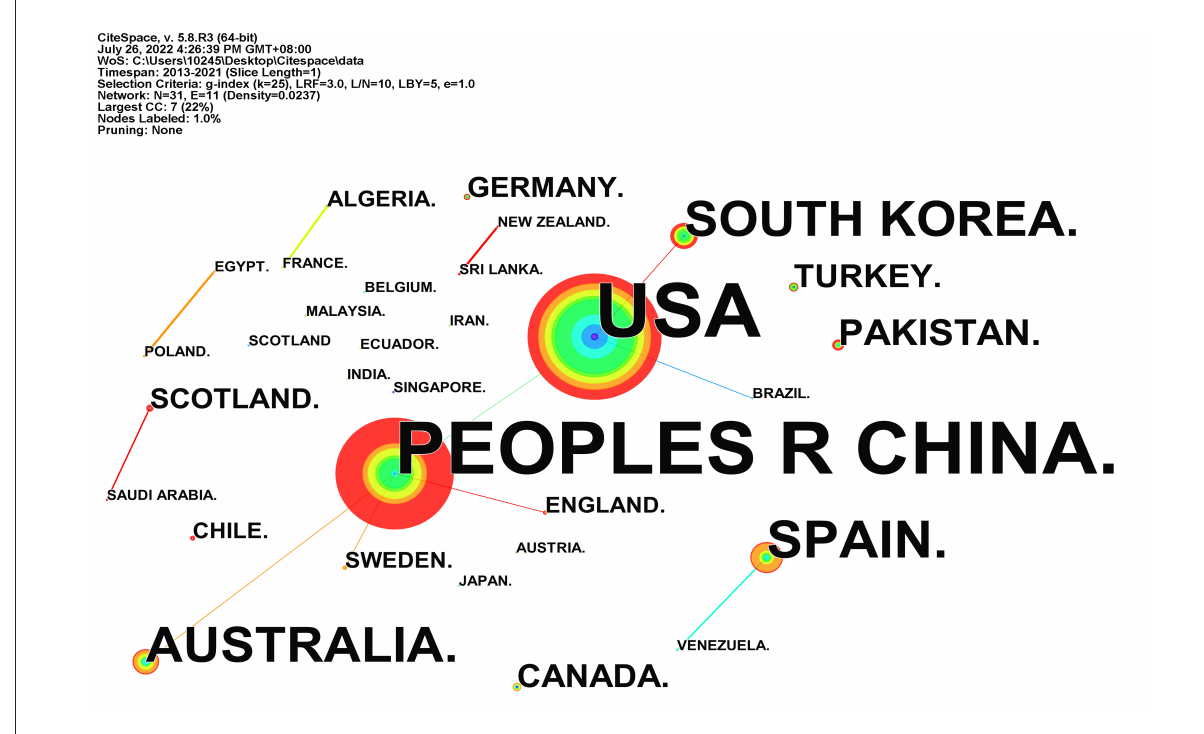
FIGURE5 National distribution mapping knowledge domains.